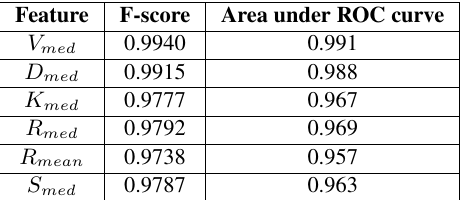
Table 1: Average feature performance based on classification us-